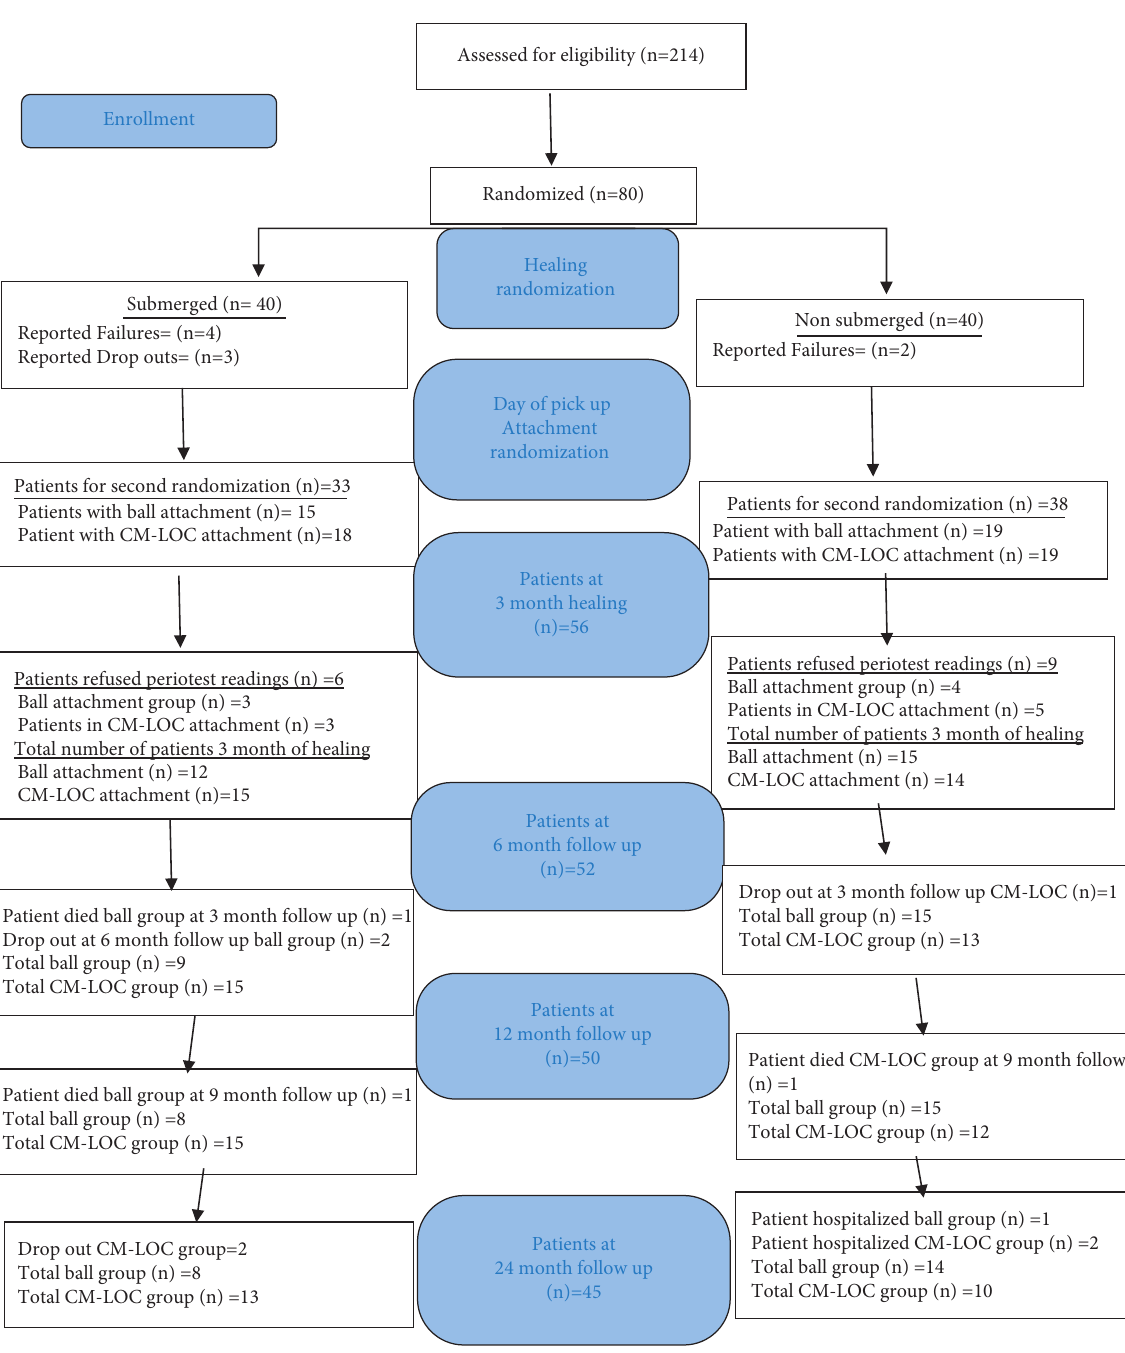
Figure 1: Consort flow